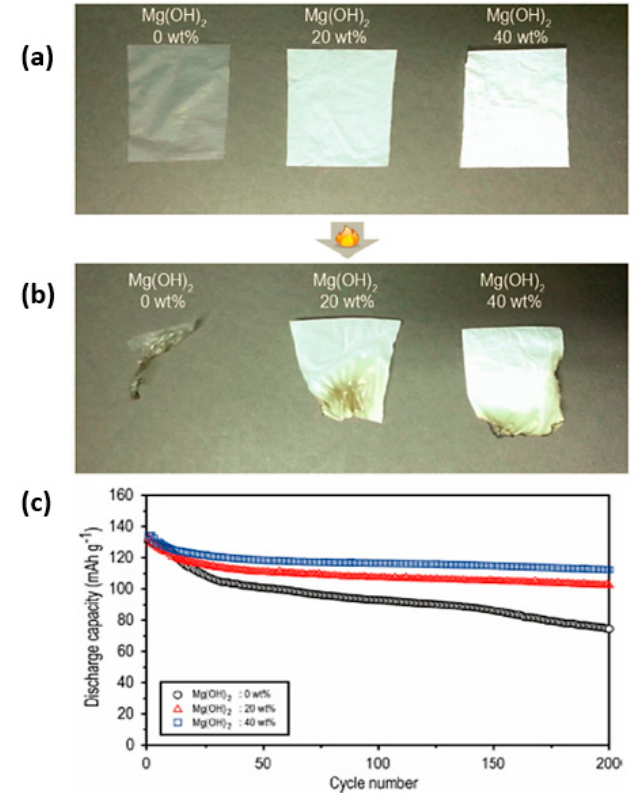
Figure 15. ( a , b ) Flame-retardant tests of composite gel polymer films with different amounts of Mg(OH) 2 . ( c ) The cycle performance of cells with composite gel polymer electrolytes with different concentrations of Mg(OH) 2 at 2C rate [52]. Reprinted with permission, ©